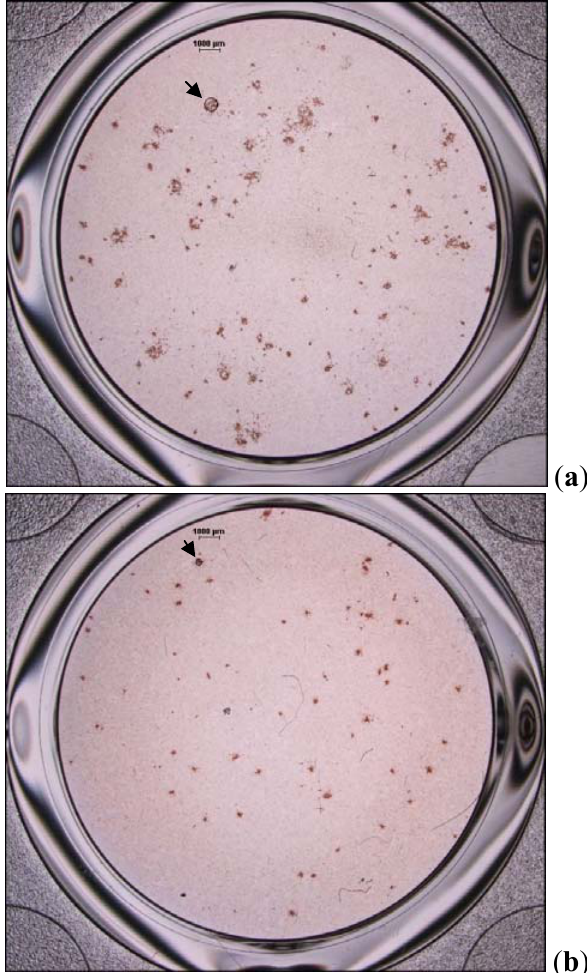
Figure 1. The effects of flavone on DENV-2 foci formation in Vero cells. Infected cells were treated with 100 µg/mL of flavone ( a ) or mock-treatment medium ( b ) during virus adsorption and attachment. Virus foci were detected after 4 days of incubation using dengue hyperimmune sera. Enlarged viral foci diameter was obvious in the flavone-treated cells